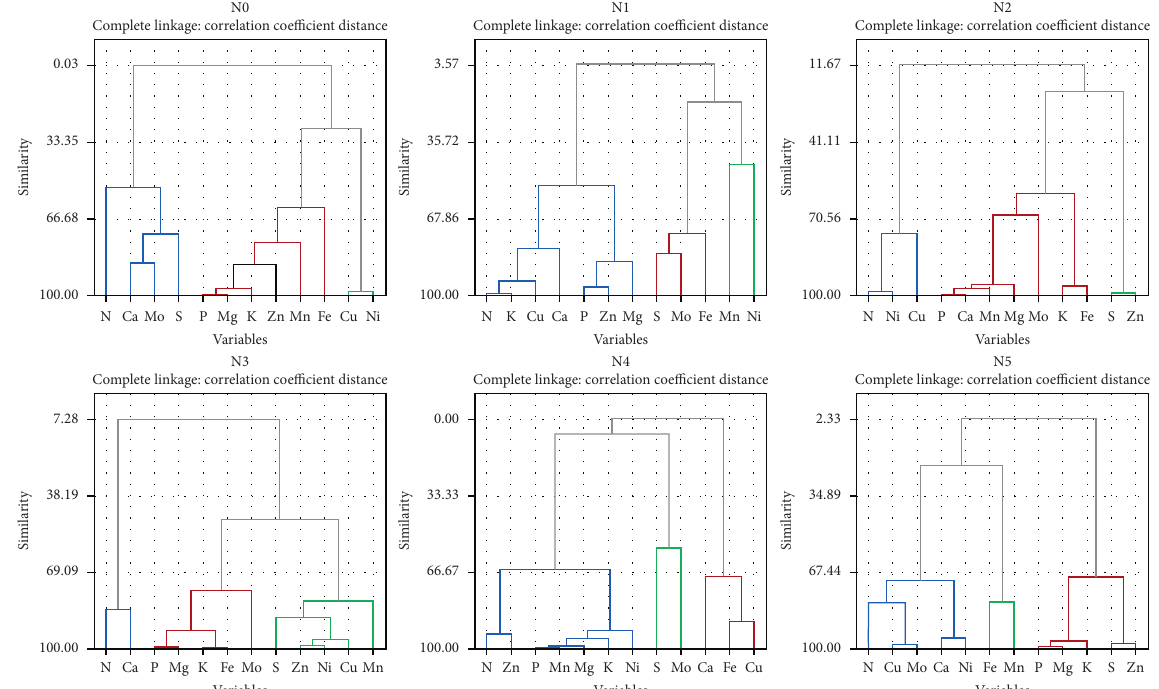
Figure 7: Cluster of NPK in nutrients of grain. Nitrogen (N), potassium (K), phosphorus (P), magnesium (Mg), calcium (Ca), sulphur (S), zinc (Zn), iron (Fe), copper (Cu), manganese (Mn), nickel (Ni), and molybdenum